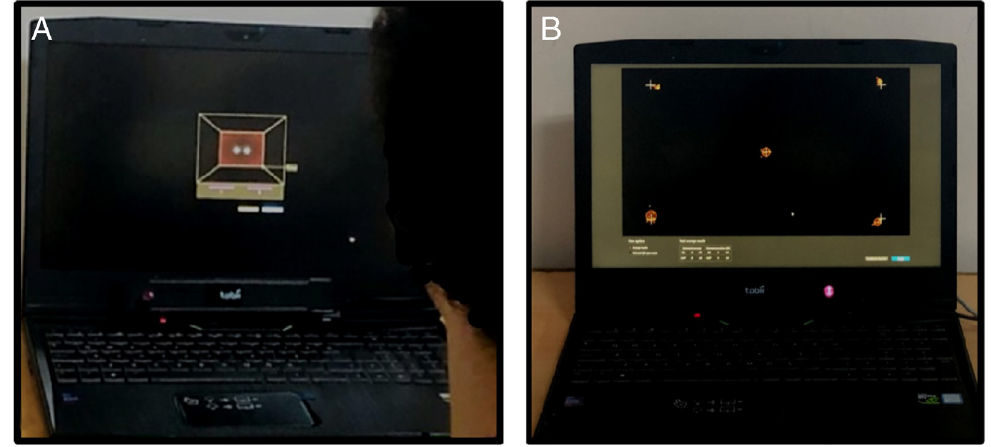
Figure 2. A. The detection of the VP eyes. B. The calibration of the VP